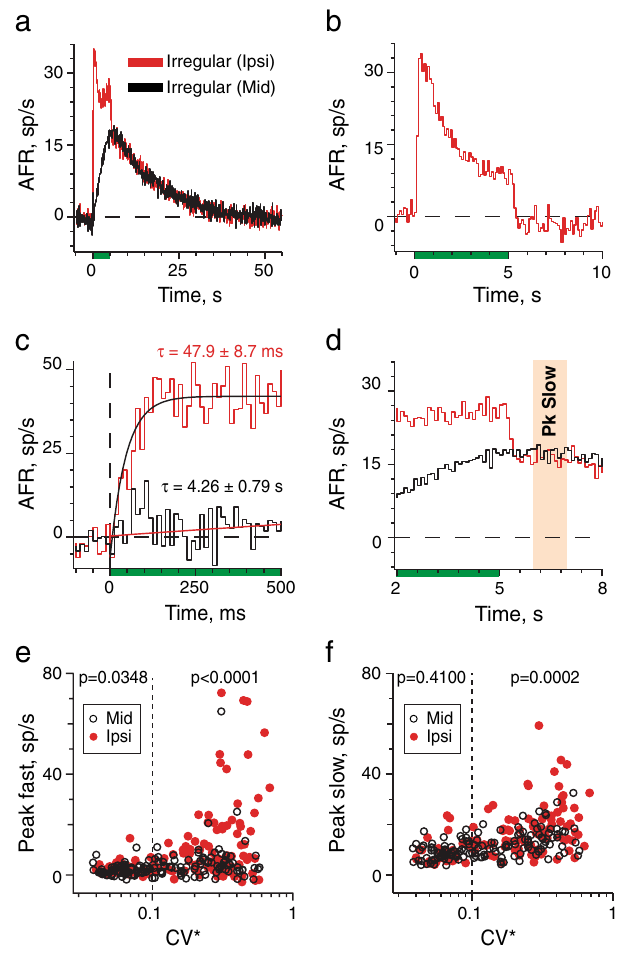
Figure 4. Efferent-mediated fast and slow excitation may be distinguished based on response activation and duration. ( a ) Ensemble mean response histograms (100 ms bins) were generated for irregular afferents during ipsilateral (red, 18 units, 108 trials) or midline efferent stimulation (black, 18 units, 74 trials). ( b ) Time course of efferent-mediated fast excitation is shown after subtracting the midline ensemble histogram from the ipsilateral ensemble histogram in panel ( a) . ( c ) Ensemble mean response histograms from panel ( a) were replotted using a smaller 12.5-ms bin size. The first 500-ms of the ensemble histograms are shown. Rise times constants were derived from exponential fits. ( d ) Expansion of panel ( a) demonstrates that estimates of slow excitation at t = 6–7 s (orange bar) exclude contributions from fast excitation. ( e ) Mean efferent-mediated fast excitation for ipsilateral and midline stimulation are plotted against CV*. ( f ) Mean efferent-mediated slow excitation for ipsilateral and midline stimulation are plotted against CV*. Total number of afferents for midline and ipsilateral stimulation are 144 (n = 65 regular, 79 irregular) and 120 (n = 34 regular, 86 irregular), respectively. Vertical dashed line separates regular from irregular afferents. Indicated p values in panels ( e,f) are from comparisons of response amplitudes in regular or irregular afferents with midline vs. ipsilateral stimulation using Mann